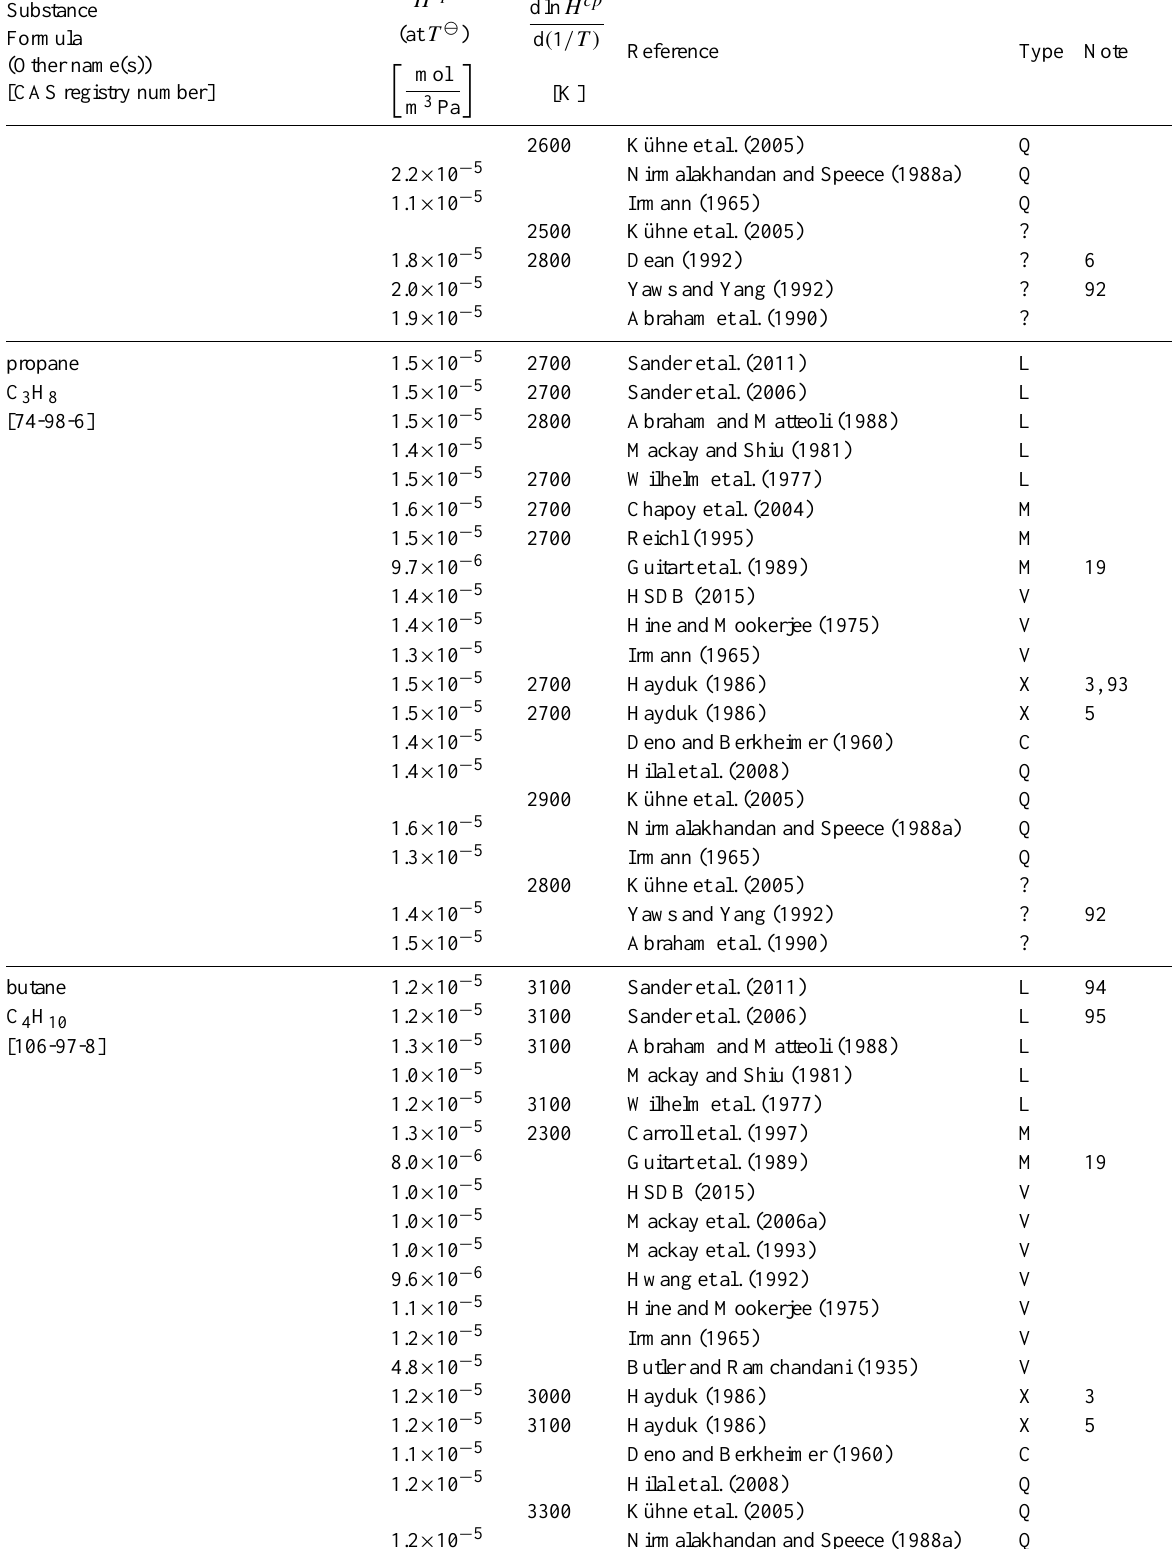
Table 6: Henry’s law constants for water as solvent